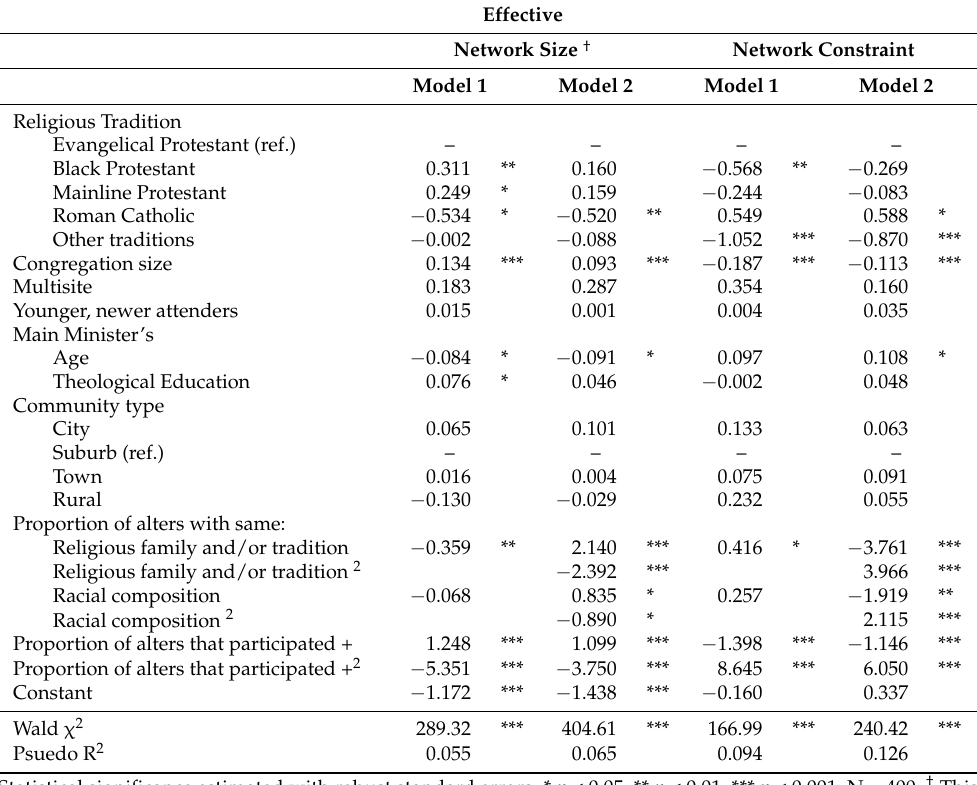
Table 2. Fractional logistic regressions predicting effective network size and network